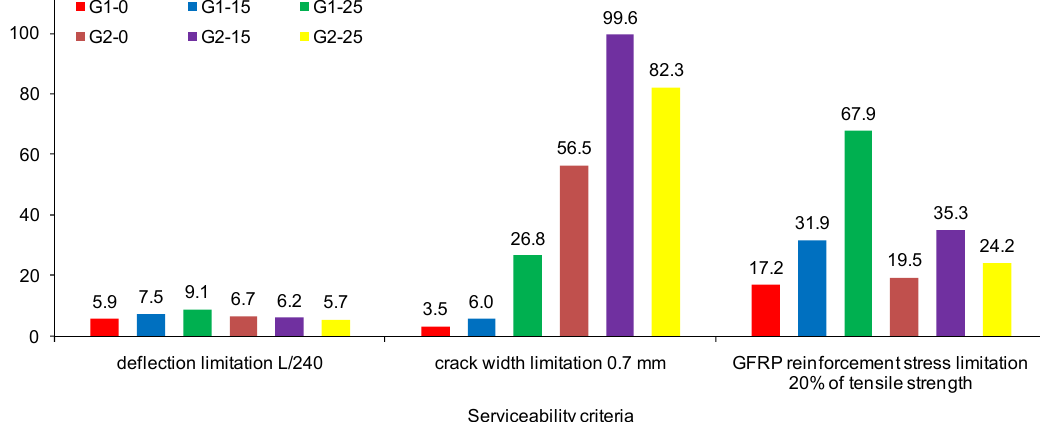
Figure 13. Deflection factors for serviceability criteria limitations for the tested beams.